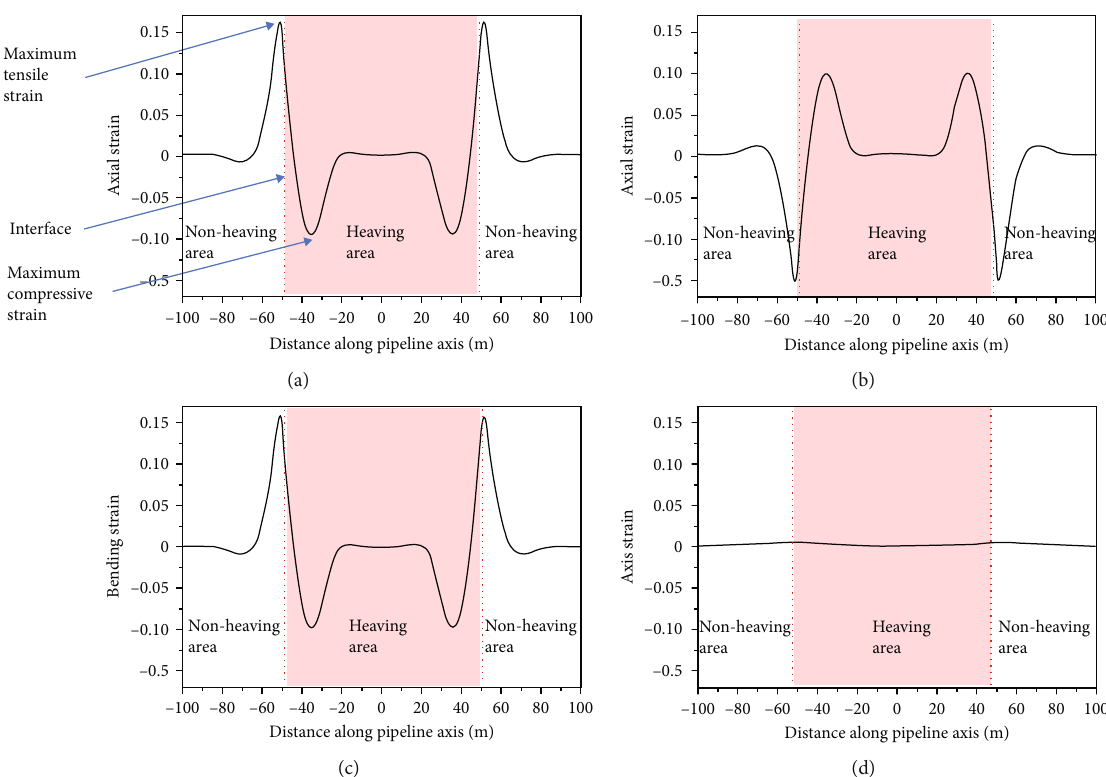
Figure 7: Pipe strain distributions under frost heave displacement of 0.4 m based on fi nite length frost heave model: (a) axial strain at pipe crown, (b) axial strain at pipe invert, (c) bending strain, and (d) axis